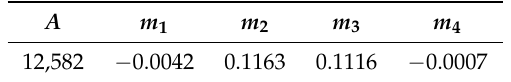
Table 2. Hansel-Spittel constitutive model parameter values.